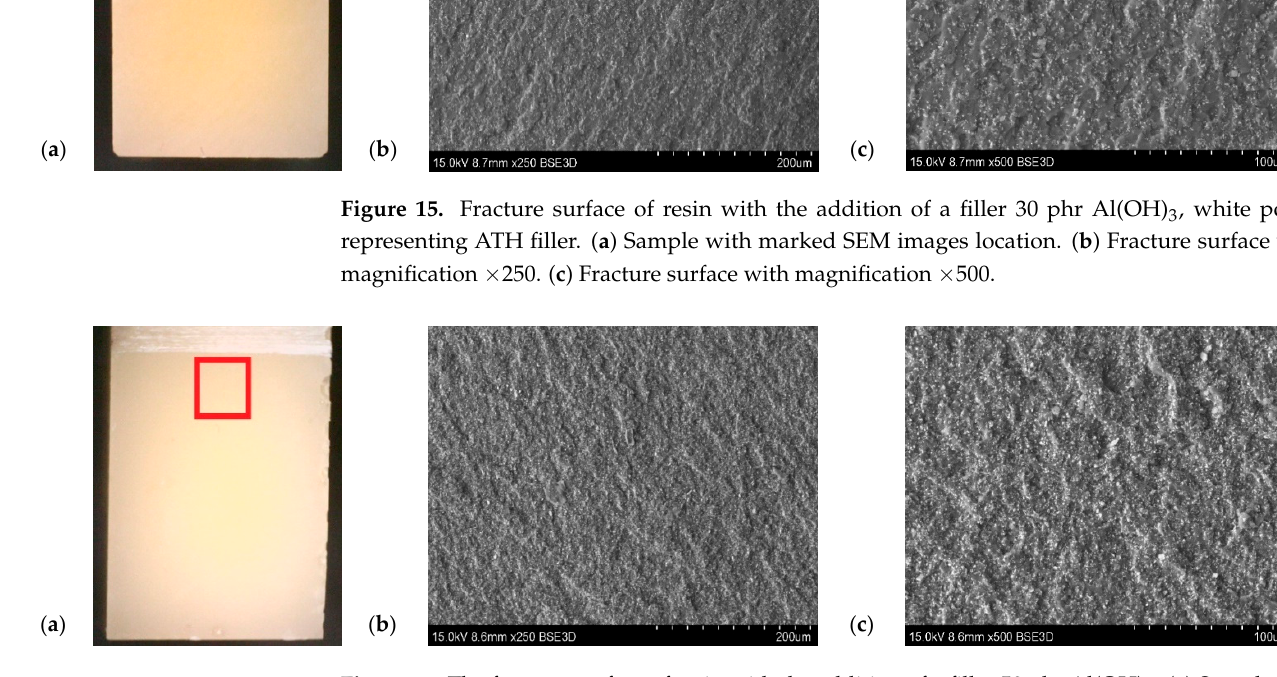
Figure 17. Results from the EDX analysis: ( a ) neat resin, ( b ) resin with 30 phr ATH, ( c ) resin with 50 phr ATH. Table 3. Content of carbon, oxygen, and aluminum elements in the sample volume. Element (wt%)